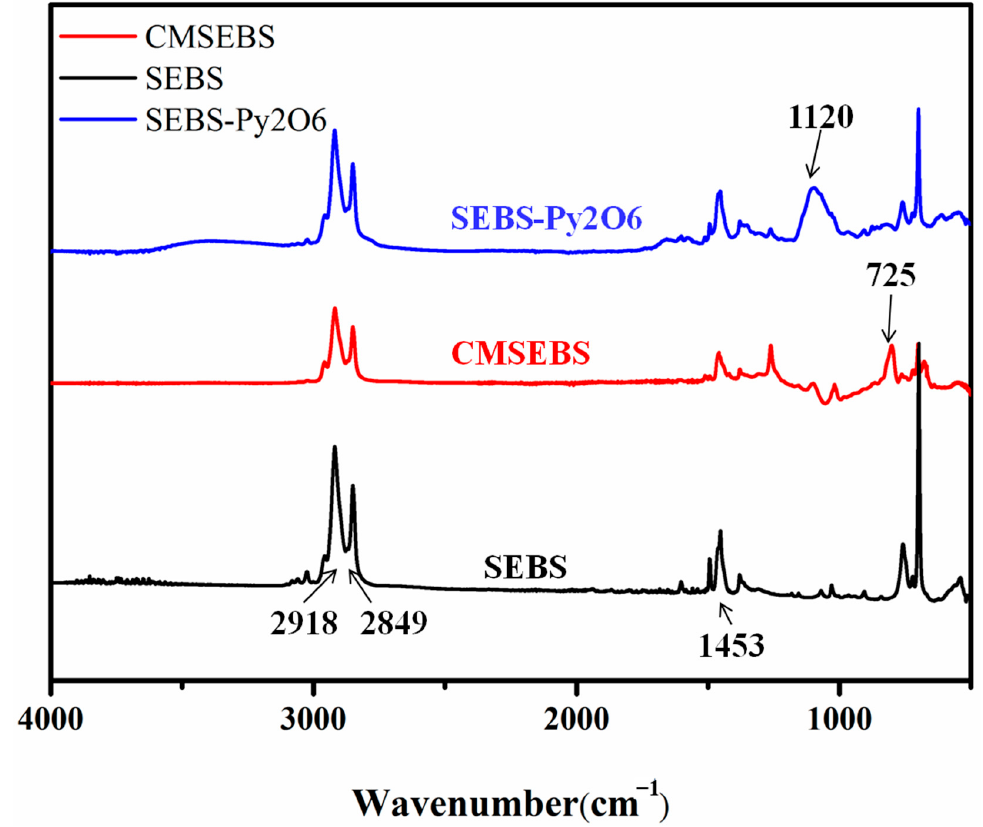
Figure 3. FT-IR spectra of SEBS, CMSEMS and SEBS-Py206